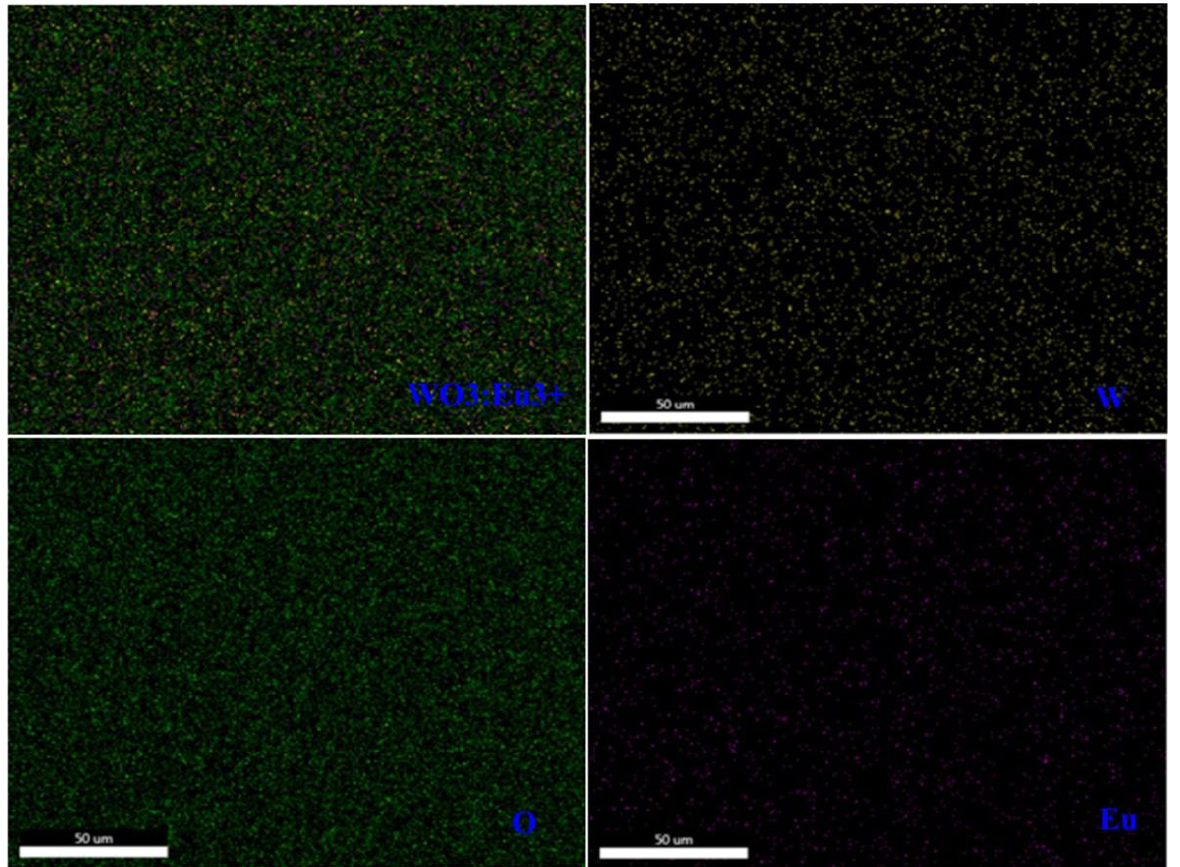
Figure 7. X-ray dot mapping image of WEu5 film. The O1s peaks of these films (WEu0 and WEu3) are presented in Figure 9b and 9d, respectively. The asymmetric peak observed in both the spectra can be de-convoluted into two symmetric peaks; one at a low binding energy position, and the other at a high binding energy position. The peak observed at the low binding energy position (530.29 eV for WEu0 and 530.19 eV for WEu3) can be assigned to the O 2- ions bonded to the W